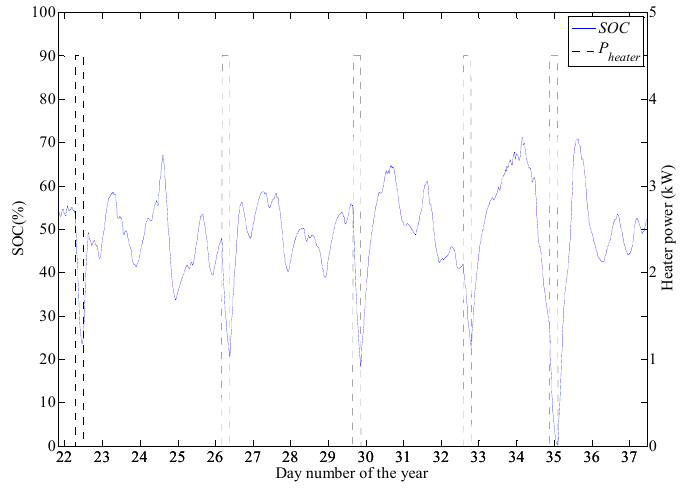
Figure 9. SOC dips (blue) due to the heater operation (dashed